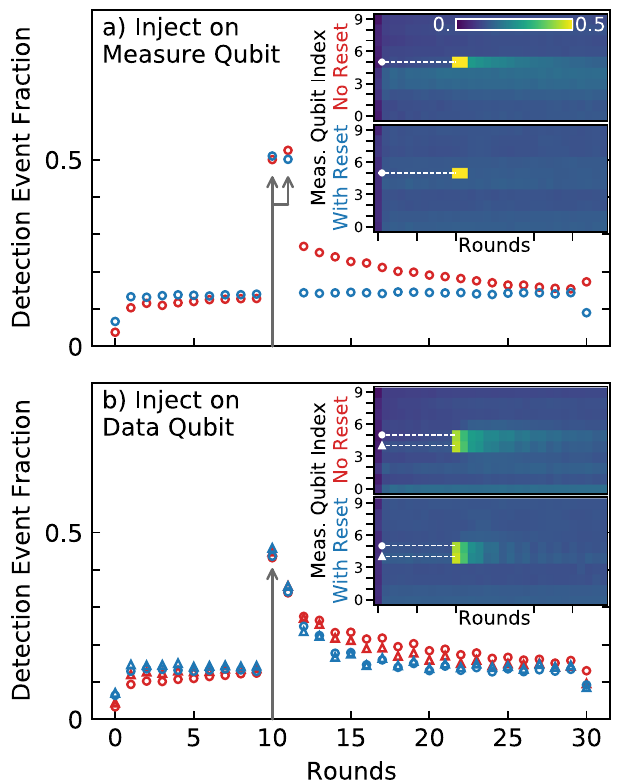
Fig. 4 Injection of leakage. Detection event fraction when a full 1 j i ! 2 j i rotation is inserted in round 10 after the fi rst Hadamards a on measure qubit 5 and b on the data qubit between measure qubits 4 (circles) and 5 (triangles). Insets show the event fraction across all measure qubits, indicating the traces plotted in the main fi gure (dashed lines). See Fig. 3 inset for qubit